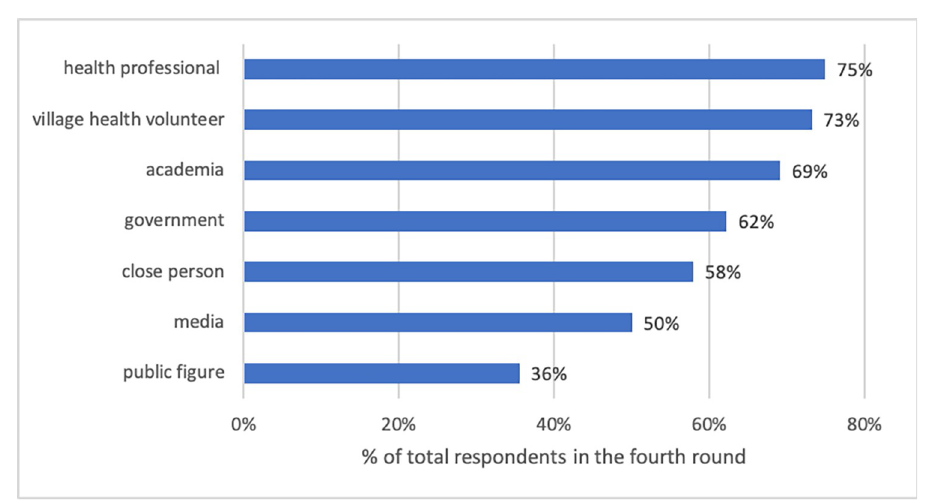
Fig 3. The proportion of respondents who trusted different sources of information. Note: n = 26,037.